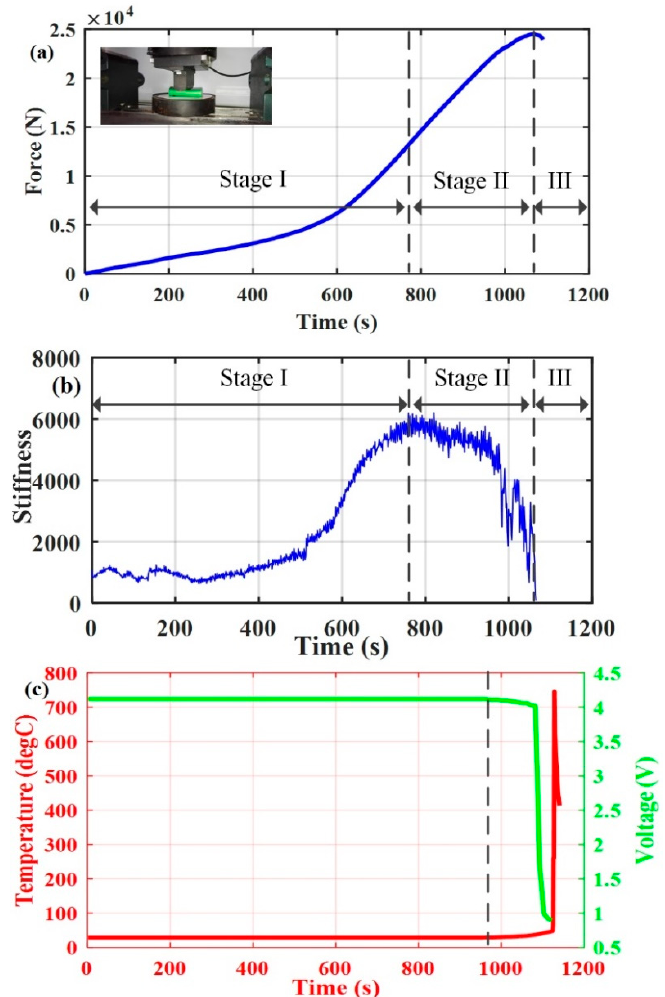
Figure 1. Testing results for fully charged Li-ion batteries during indentation tests. ( a ) Force–time curve, ( b ) stiffness derivative of force versus time, and ( c ) voltage and temperature responses.